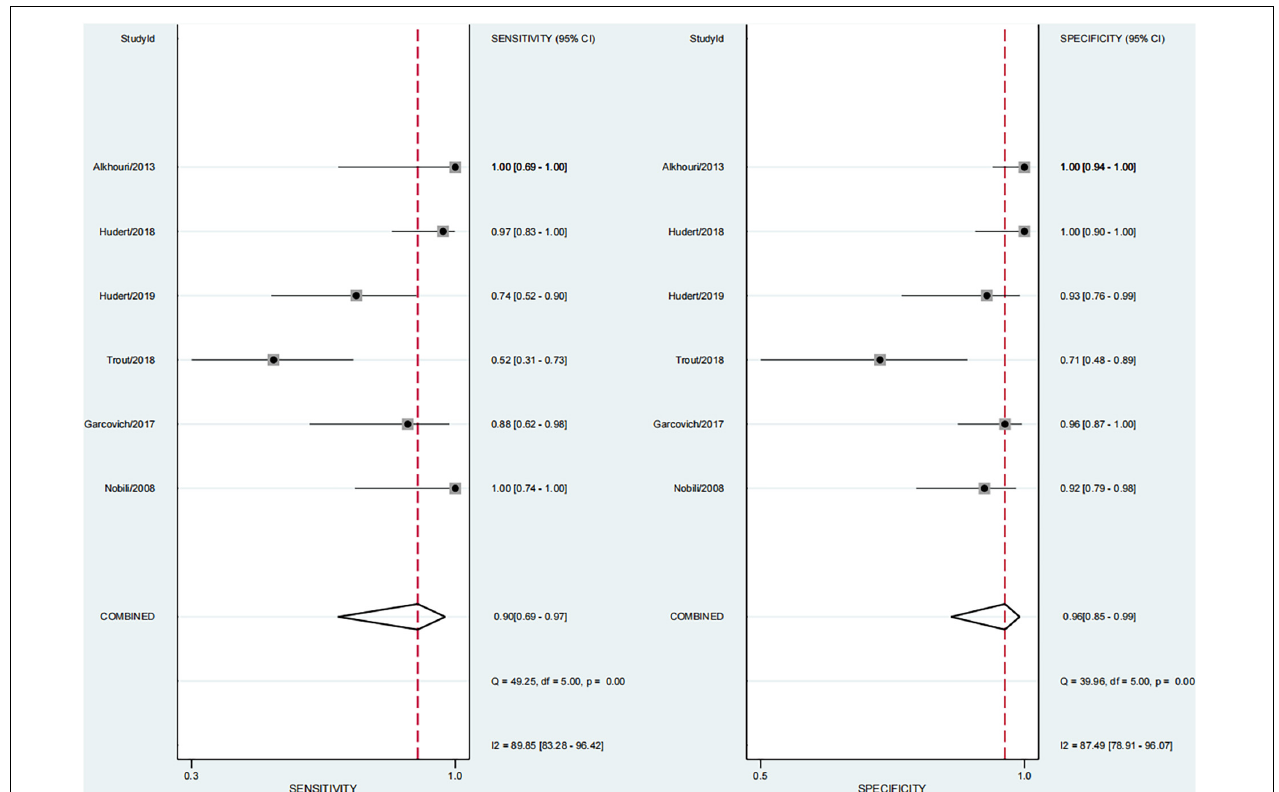
and found that the serum ALT level was abnormal in 12 of 13 cases (44). No uniform threshold was available for diagnosing NAFLD in children due to restrictions such as sex, ethnicity,